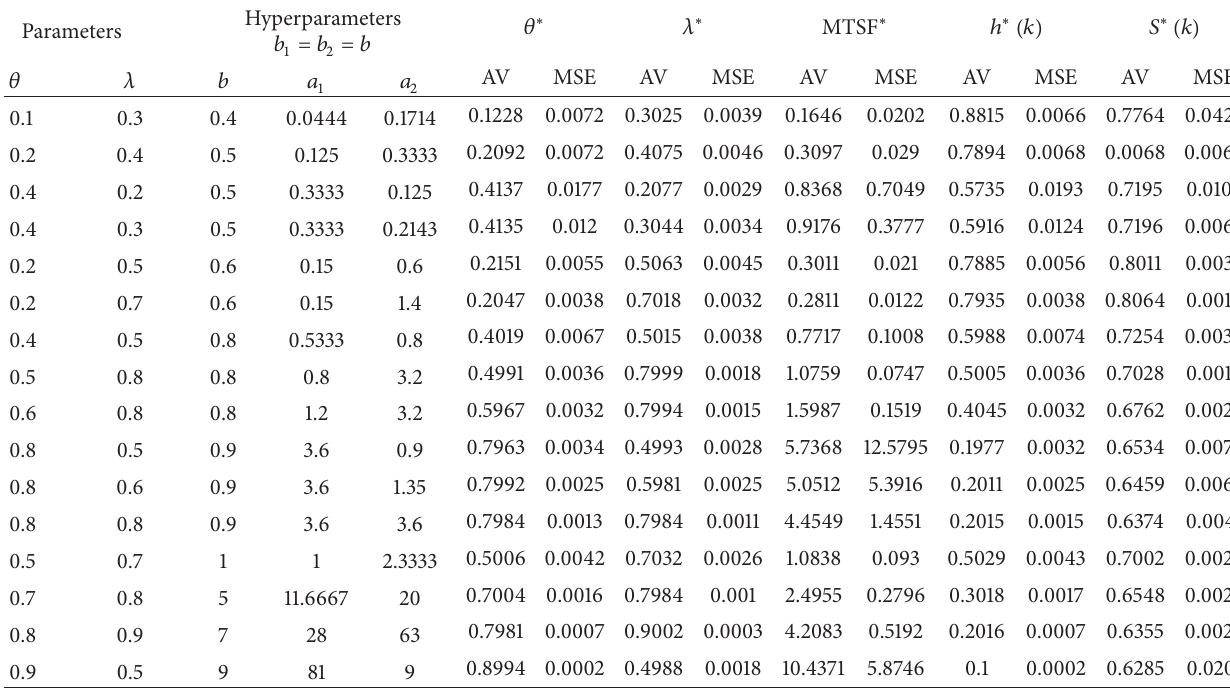
Table 7: Bayes estimates under